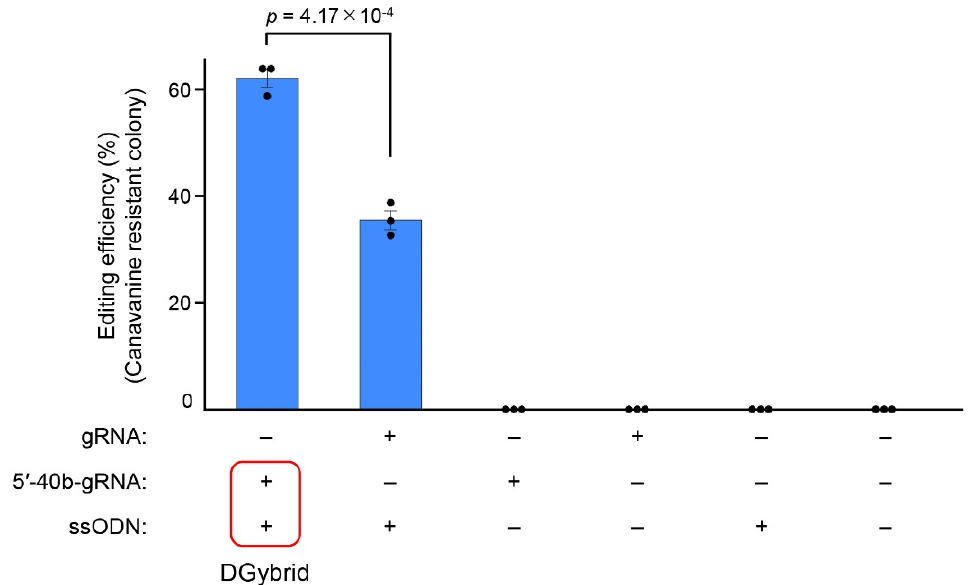
Figure 4. Evaluation of the DGybrid-based genome-editing efficiency. The genome-editing efficiency was evaluated by counting the number of canavanine-resistant colonies. Error bars represent the SEM of three biological replicates starting from independent electroporation of nucleic acid solutions. Points represent each experimental data set. A two-tailed Student’s t -test was used to assess the statistical significance.